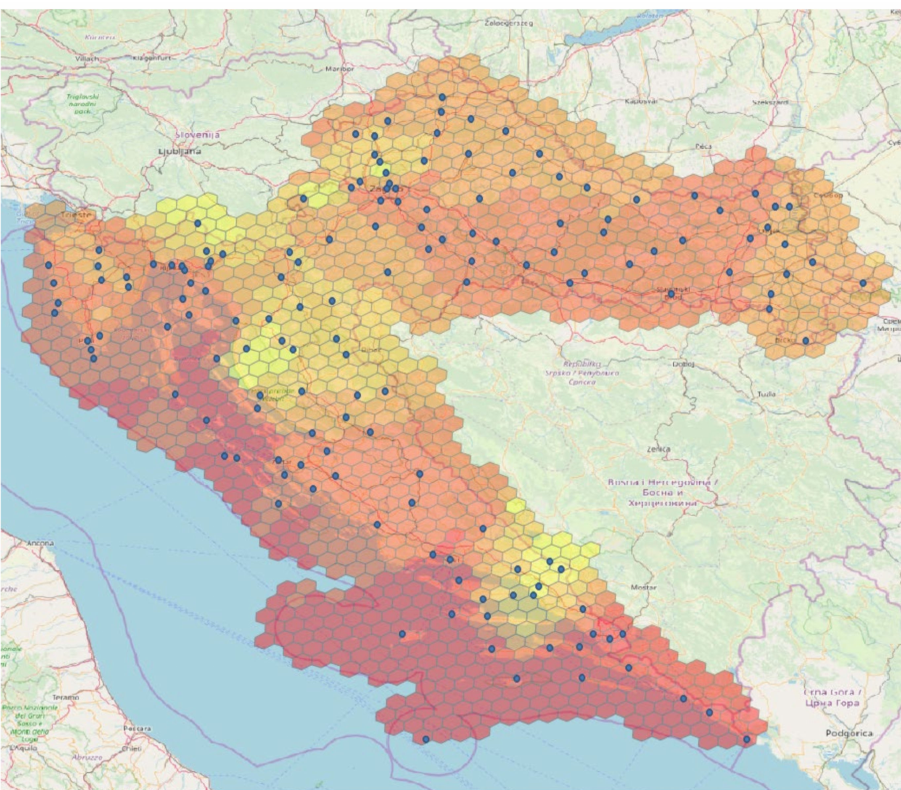
Figure 1. Blue dots represent weather stations. The values from weather stations are interpolated at each centroid of the hexagons. The color, from yellow to red, represents temperature